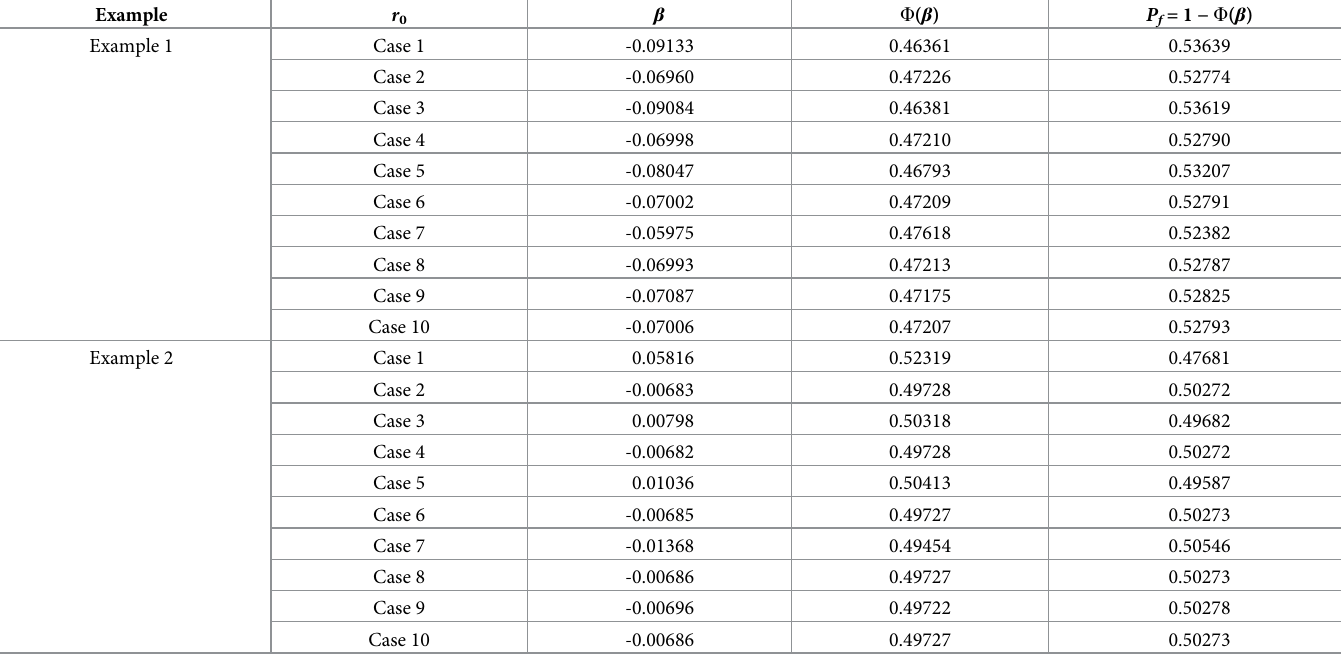
Table 4. Safety index and failure probability for each of the ten